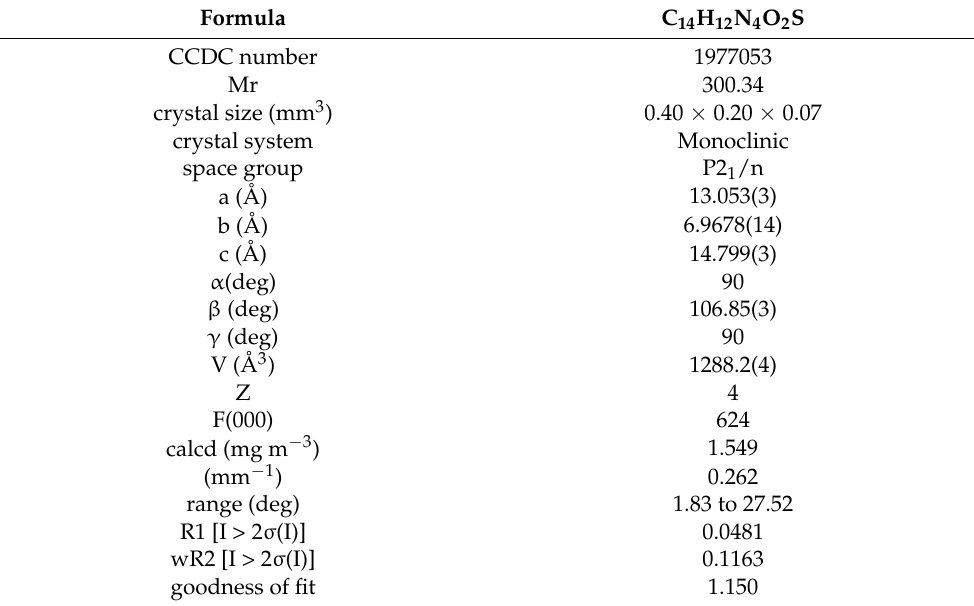
Table 1. Crystal structure data of